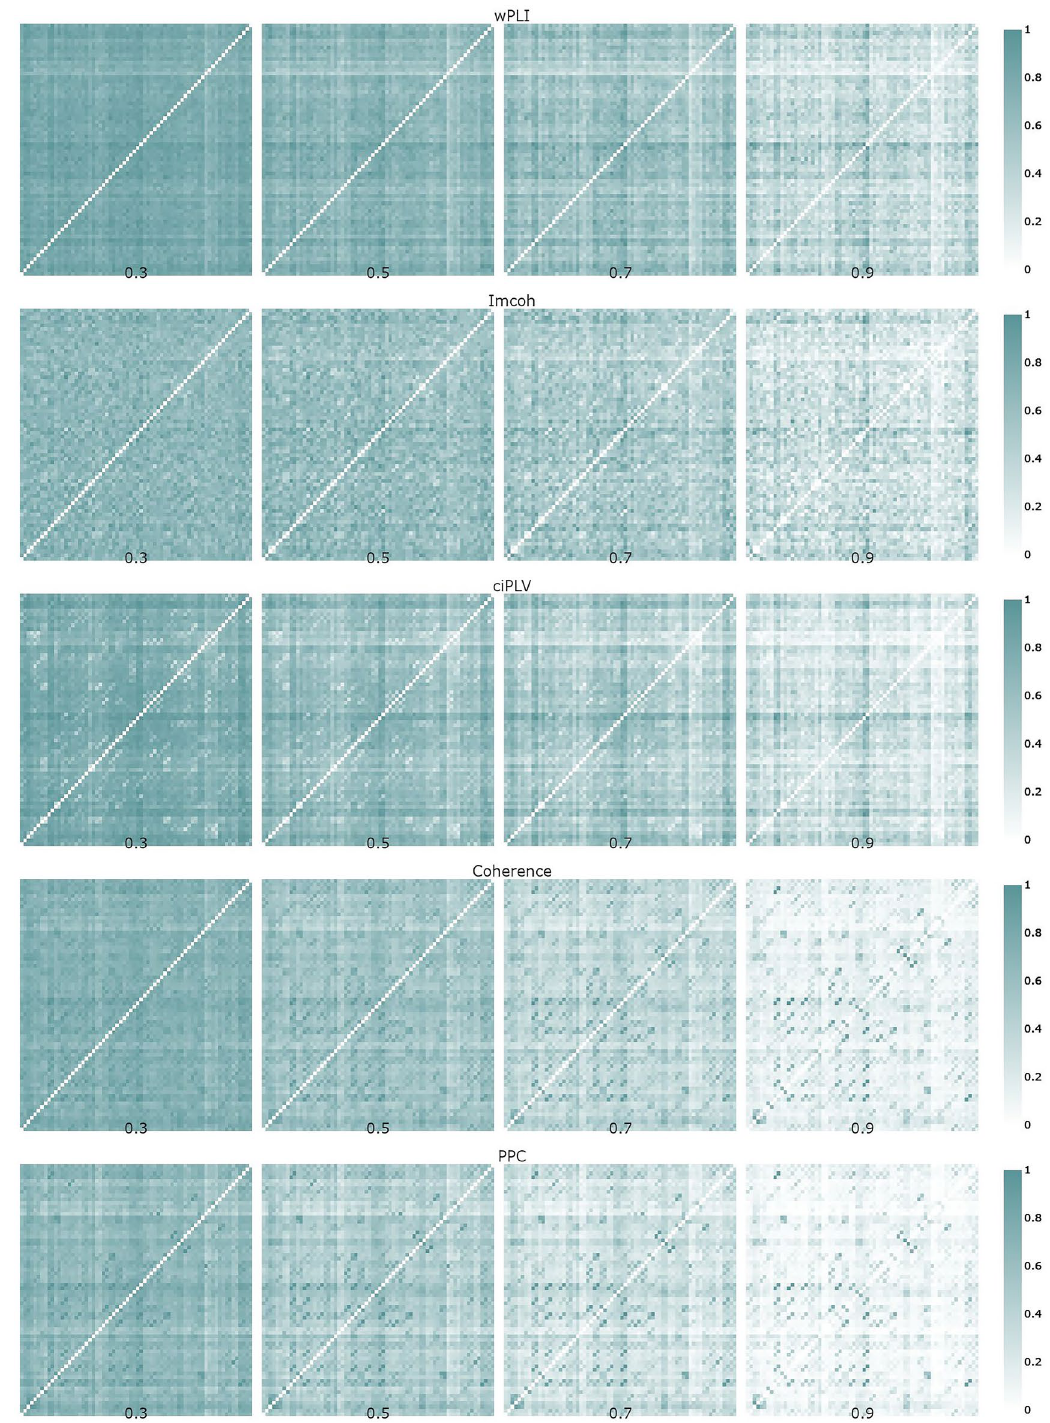
Figure 6. Edge probability graphs across different thresholds in source space. The brightness of cells reflects the relative probability of edge existence. Brighter cells are more frequent in the individual networks in the sample. The edge weights were scaled to the range [0, 1] across all thresholds. Plotly 5.3.1 (https:// plotly. com/ python/) was used to create this